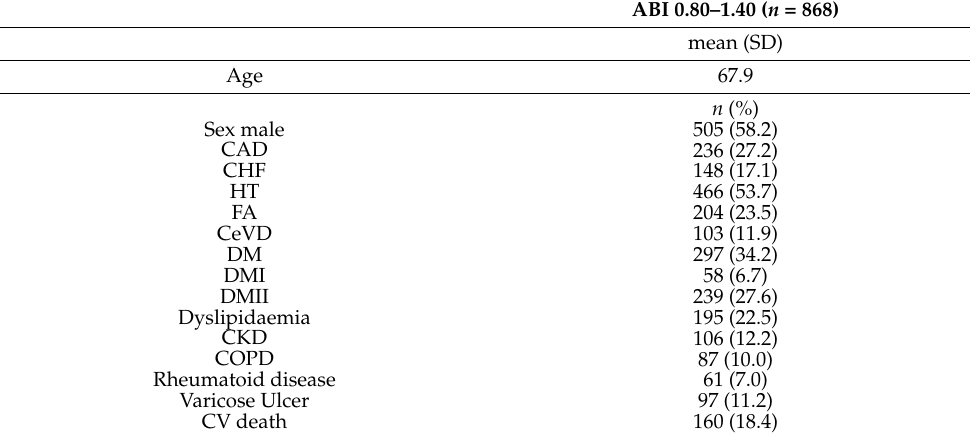
Figure 1. Flow chart of the study. Patients with bilateral ankle–brachial index (ABI) 0.80–1.40 were included in the initial survival analysis. Table 1. Demography for study cohort of 868 patients with ABI